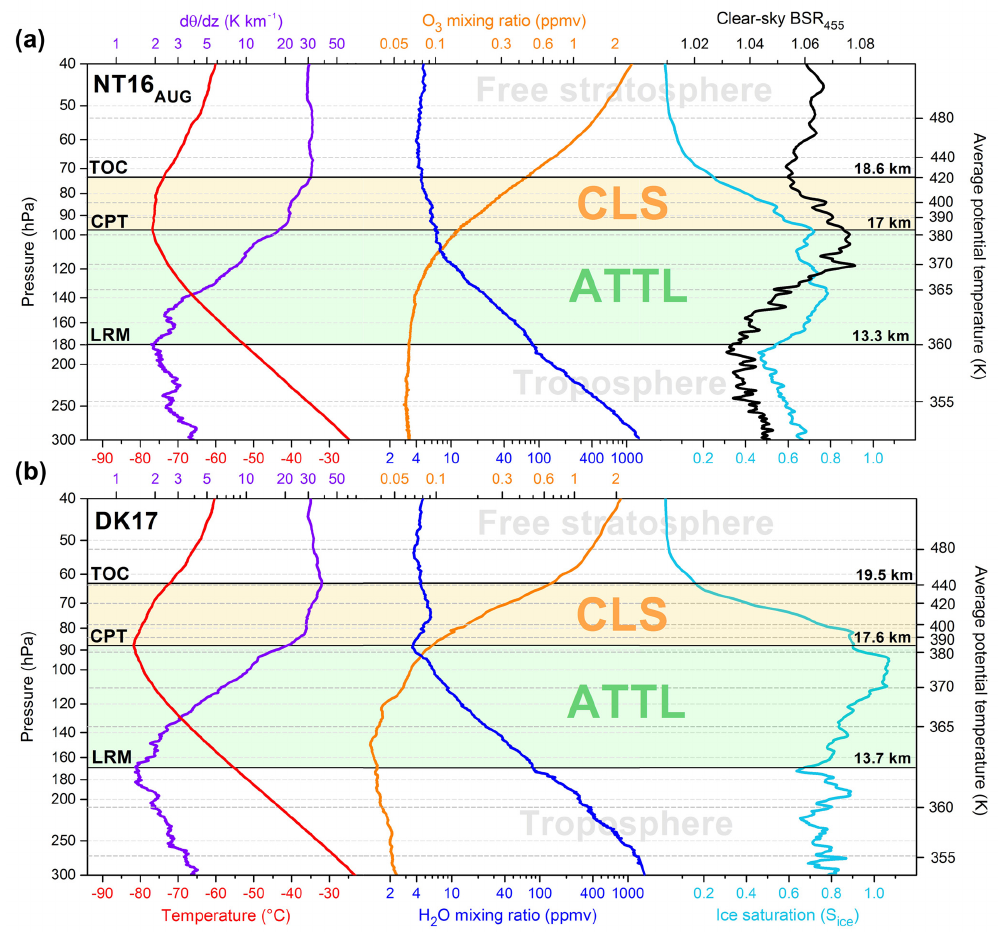
Figure 12. Mean profiles of temperature (red), d θ/ d z (purple), the H 2 O mixing ratio (blue), the O 3 mixing ratio (orange), ice saturation (light blue) and clear-sky aerosol BSR 455 (black) as a function of pressure (left axis, light grey dashed lines) for NT16 AUG (a) and DK17 (b) . Average potential temperature levels are shown on the right axis and marked by dark grey dashed lines. Note that the pressure scale is the same for the two panels, and the potential temperature levels vary according to the measurements. The average CPT, LRM and TOC levels in the two datasets are marked by black solid lines. The ATTL and CLS layers are highlighted using light green and orange shading, respectively. Note that the mean profiles of d θ/ d z , ice saturation and clear-sky aerosol BSR 455 are smoothed with a ± 5hPa (about 250m) moving average (same as in Fig. 4).